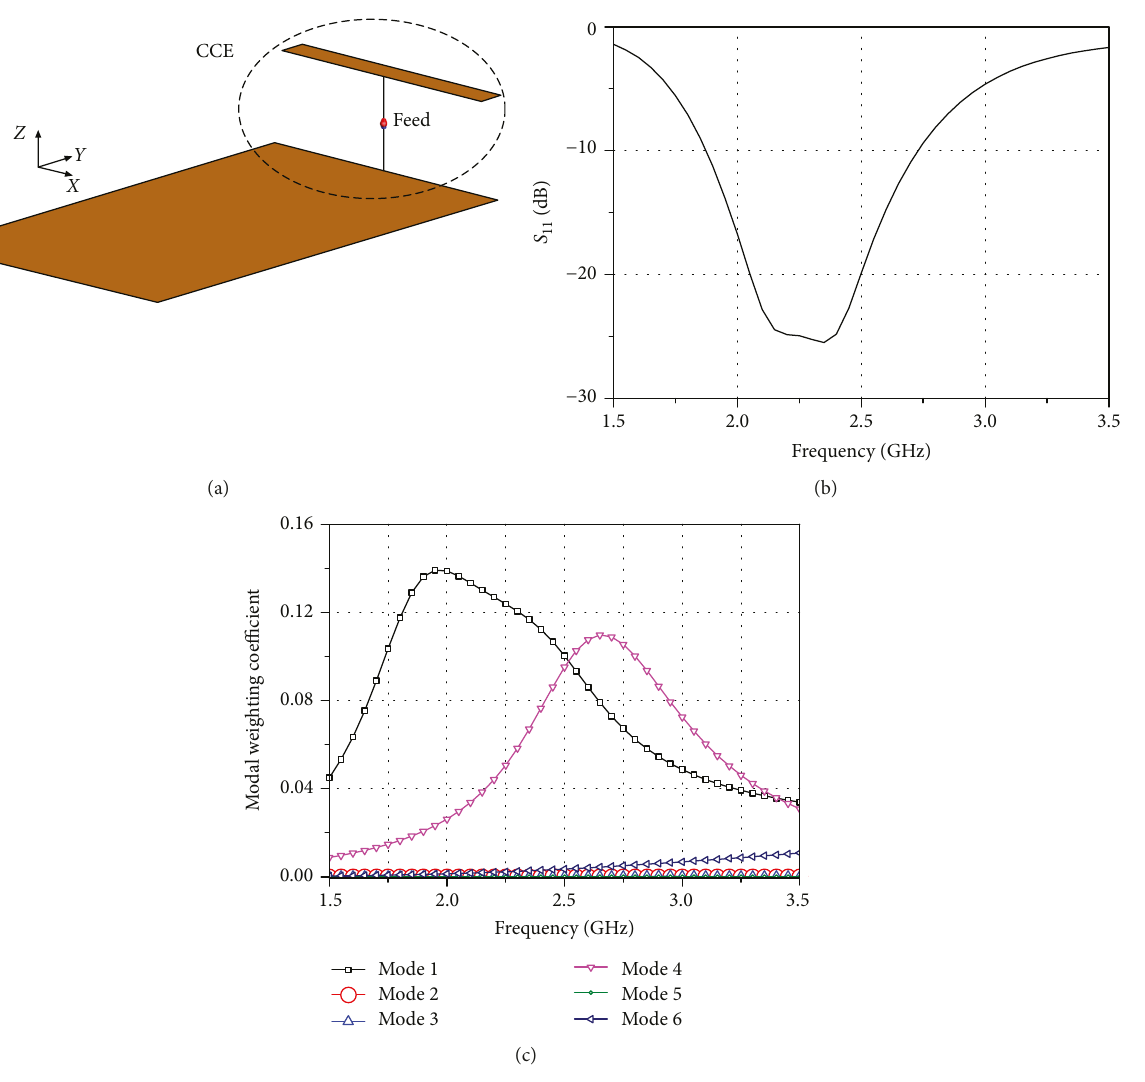
ffi cients: (a) 11 parameters and modal weighting coe